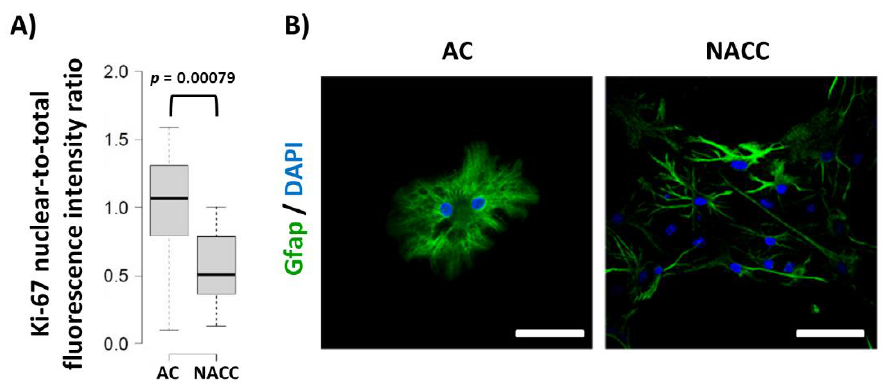
Figure 3. Changes in Ki-67 protein-related nuclear-to-total fluorescence ratio and morphology of astrocytes under different culture conditions. ( A ) Quantification of changes in Ki-67 protein-related fluorescence normalized to control group. ( B ) Morphology of astrocytes stained with anti-Gfap antibodies. DAPI counterstains nuclei. Bar = 50 µ m. AC—astrocytic monoculture; NACC—neuron–astrocyte co-culture. The experiment was repeated in triplicate.